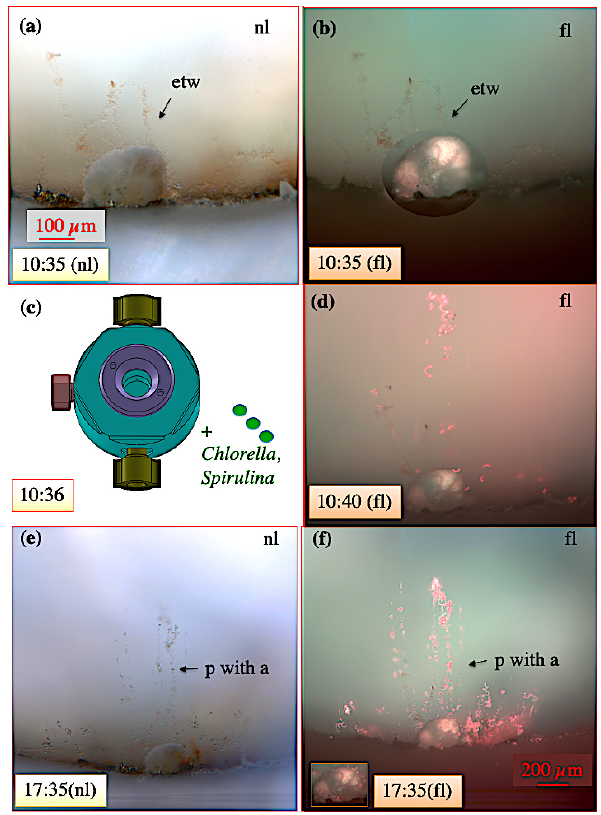
Figure 9. Pseudopodial network of C. pachyderma specimen 1 dur- ing feeding on 13 April 2017. Specimen 1 before, during, and af- ter feeding with 0.5µg dried Spirulina and Chlorella algae. The bright red colour of dispersed algae under fluorescent light provides an excellent tool to document the passage and uptake of algae in the pseudopodia and cytoplasm. (a–b) Specimen 1 prior feeding. (c) Schematic illustration of the aquaria indicating the start of feed- ing. (d) Specimen 1 during feeding. (e–f) Seven hours after feed- ing. “etw” denotes ectoplasmic twig; “p” denotes pseudopod; “a” denotes algae; “nl” denotes normal light; “fl” denotes fluorescence light. Numbers state the respective time on 13